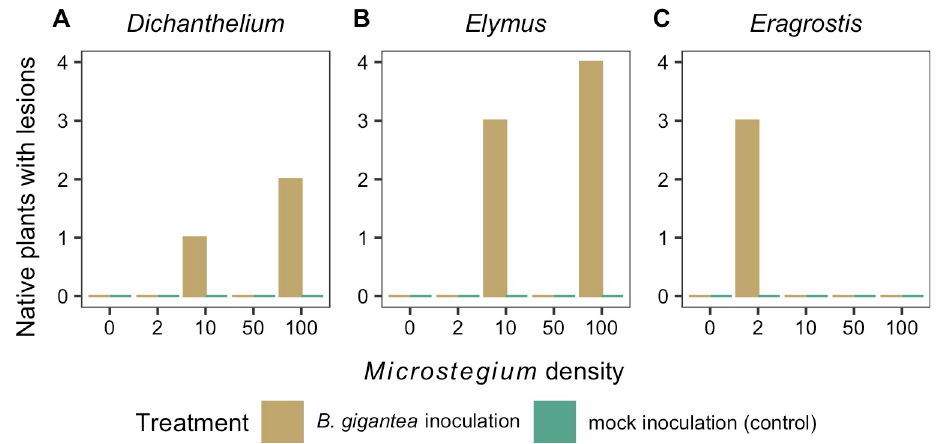
Fig 3. Native plant disease. The number of (A) Dichanthelium , (B) Elymus , and (C) Eragrostis plants with foliar lesions (out of four replicates) following B . gigantea or mock inoculation across the Microstegium density gradient.